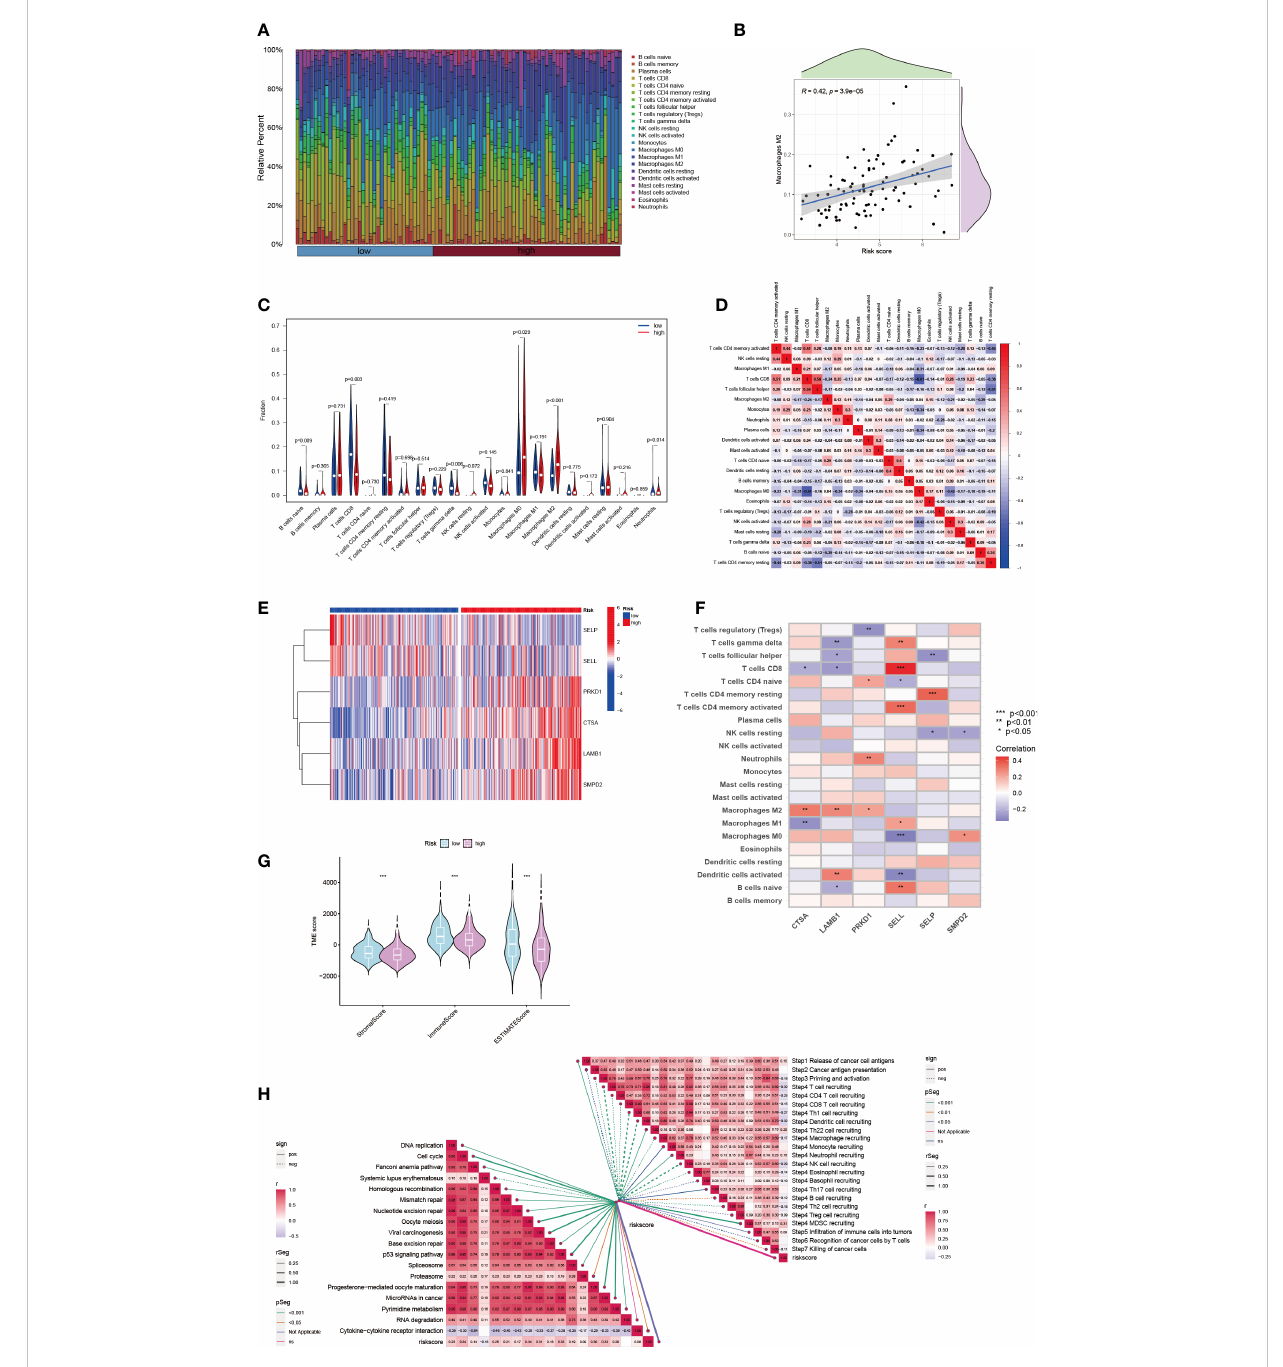
FIGURE 5 HCC immune microenvironment at differential risk score. (A) Risk score associated with different proportions of in fi ltrating immune cells. (B) Correlation between risk score and Macrophage M0 cells in HCC tissues. (C) A comparison of immune cell components between high-risk and low- risk groups. (D) Correlation between immune cells. (E) Expression patterns of 6-SPGs. (F) Correlation between immune cells and 6-SPGs. (G) Estimate score of the risk subgroups. (H) Correlation between riskscore and cancer-immunity cycle as well as functional pathways. (Wilcox test, * P < 0.05, ** P < 0.01, *** P <